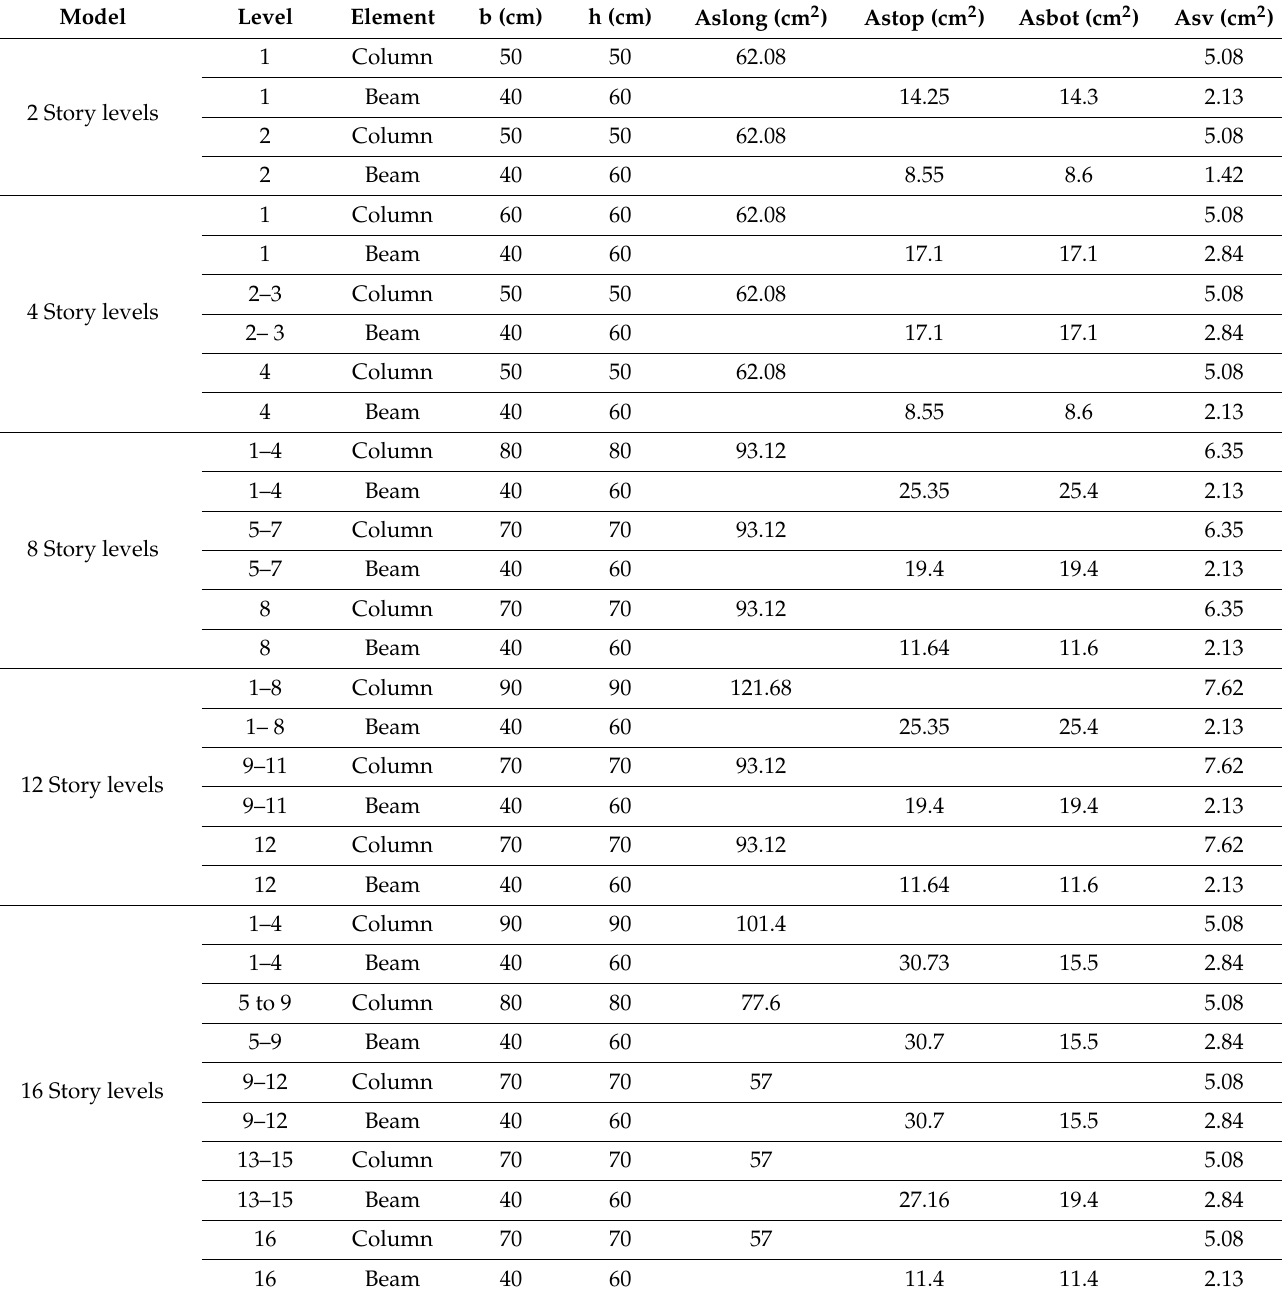
Table 1. Variations of the beams and columns designed according to COVENIN 1756-1